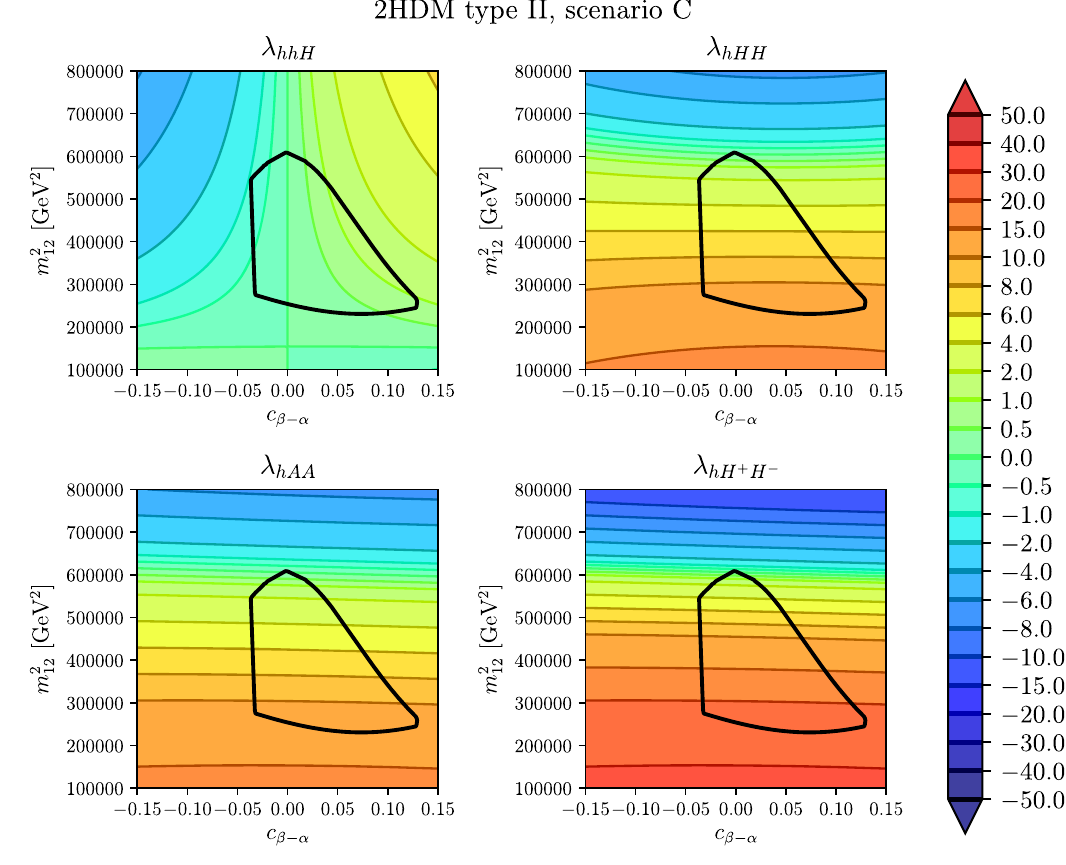
) plane for m = m = m = 1100 GeV, H A H ± 12